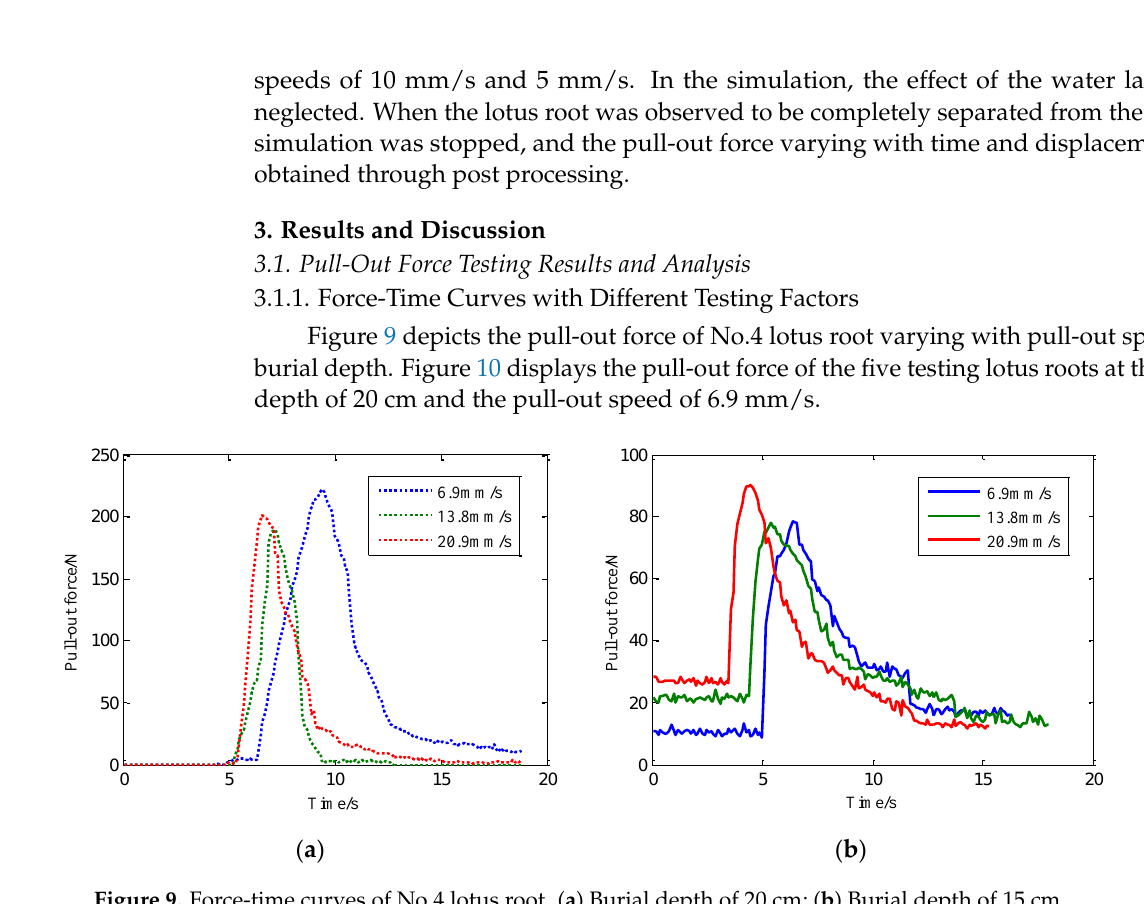
Figure 9. Force-time curves of No.4 lotus root. ( a ) Burial depth of 20 cm; ( b ) Burial depth of 15 cm.